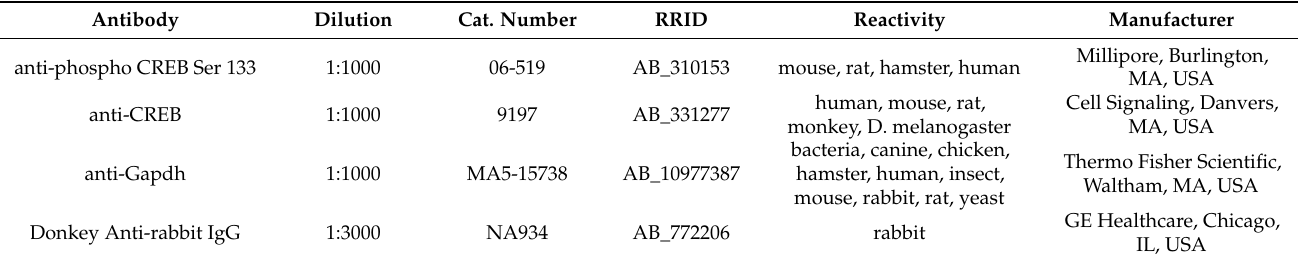
Table 2. Antibody